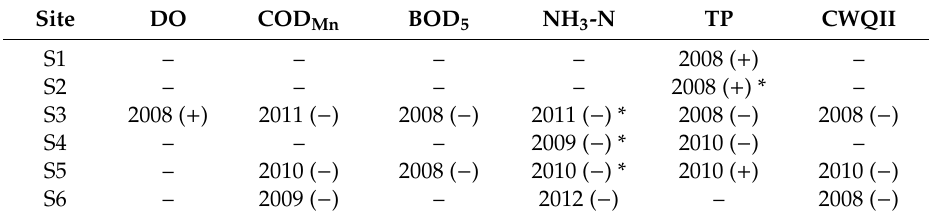
Figure 7. The result of the sequential Mann–Kendall test for the time series of NH 3 -N in S5. Table 2. The year of abrupt change of the five water quality parameters in each site.